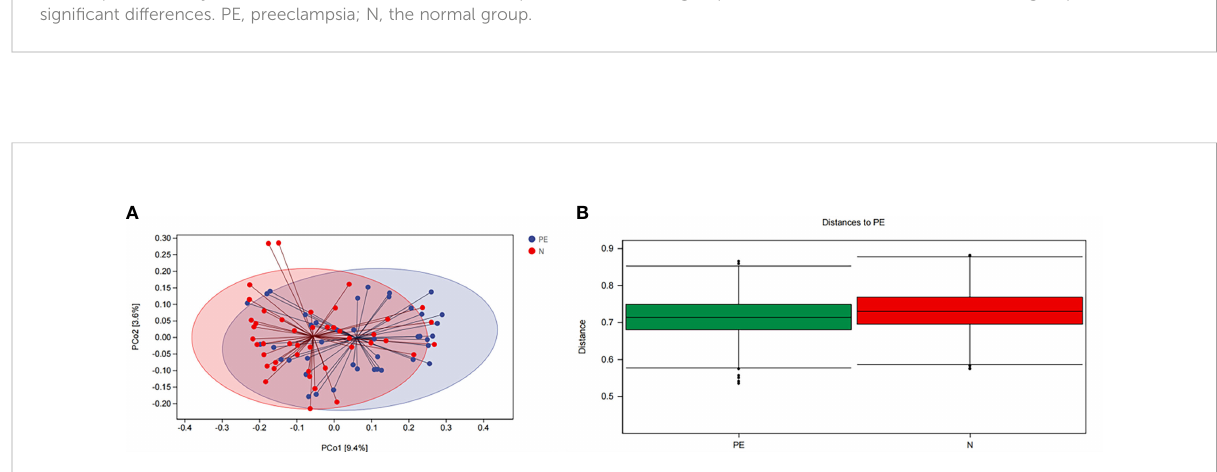
FIGURE 3 The bacterial micro fl ora composition in beta diversity between the two groups. (A) PCoA plot showing the dispersal of microbiota, (B) Analysis of similaritied (ANOISM) analysis. PE, preeclampsia; N, the healthy normal group. PCo1, The fi rst principal coordinate; PCo2, The second principal coordinate; PCoA, Principal coordinate